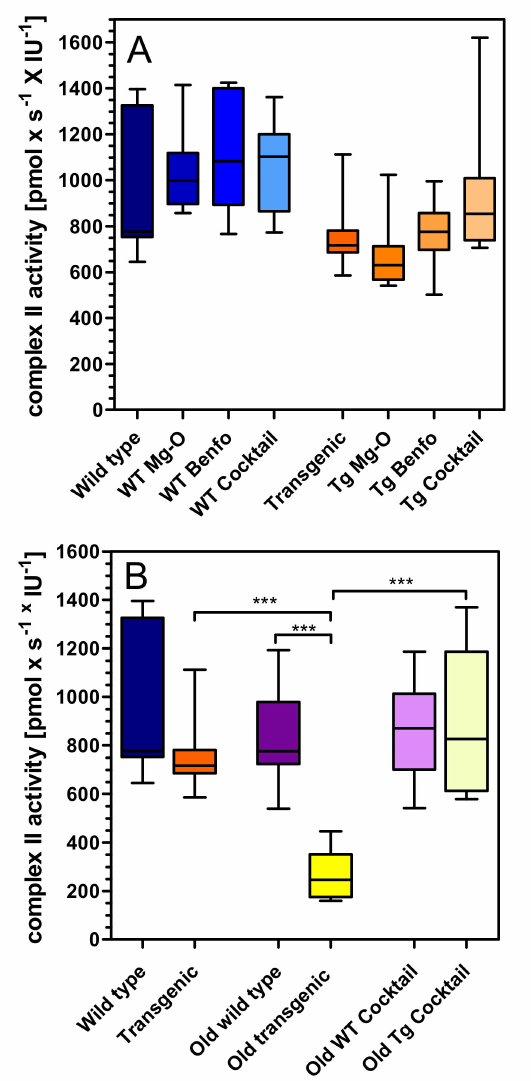
Figure 3. Oxygen flux of complex II in ( A ) young wild-type and transgenic rats and ( B ) young and old rats treated with cocktail. Substrates, uncoupler and inhibitors were used to measure complex II as described in methods. Raw data were normalised to mitochondrial citrate synthase activity. A: (left) Treatment in wild type (WT), (right) treatment in transgenic (Tg) animals. Statistical analysis: Data are box plots (lower and upper quartile) with whiskers ( n = 7–10) and were analysed by one-way ANOVA followed by Bonferroni’s multiple comparison test: (a) F3,36 = 0.99, p = 0.41; (b) F3,33 = 2.44, p = 0.08. B: Genotype, treatment and age related effects. Statistical analysis: Data are box plots (lower and upper quartile) with whiskers ( n = 7–10) and were analysed by unpaired t -test. *** p < 0.001. In line with the findings listed above, OxPhos capacity was significantly lower in young transgenic rats compared to wild-type rats ( − 51%, p < 0.01) (Figure 4). Cocktail treatment significantly improved OxPhos respiration by 34% in young transgenic rats ( p < 0.01; Figure 4A) but not in young wild-type animals. The age-related decrease of OxPhos capacity was 43% in wild-type and 66% in transgenic rats ( p < 0.01; Figure 4B). In old rats, OxPhos respiration was 71% lower in transgenic than in wild-type rats ( p < 0.01). Cocktail treatment was inactive in old wild-type animals but completely restored OxPhos respiration in old transgenic animals (+78%; p <